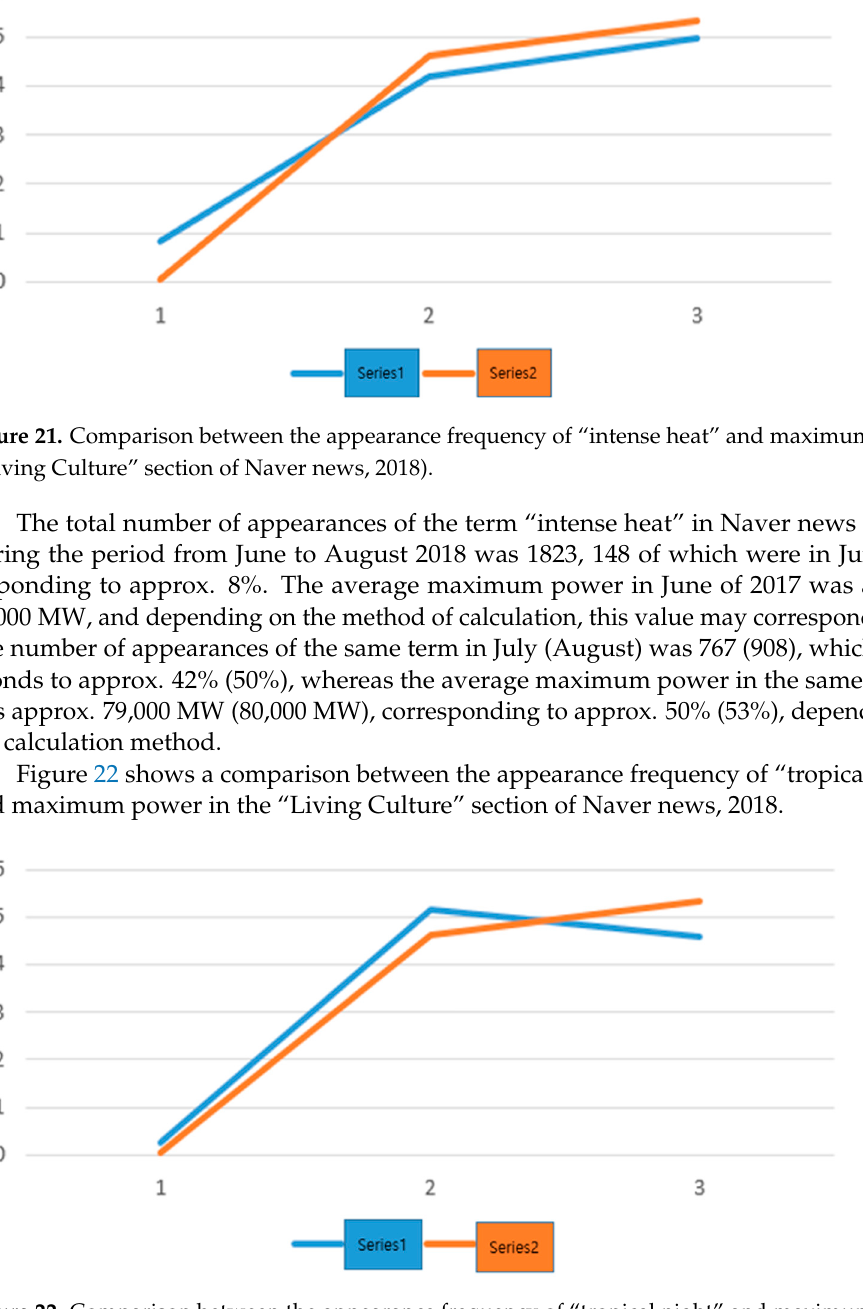
Figure 20. Comparison between the appearance frequency of “mosquito” and maximum power.